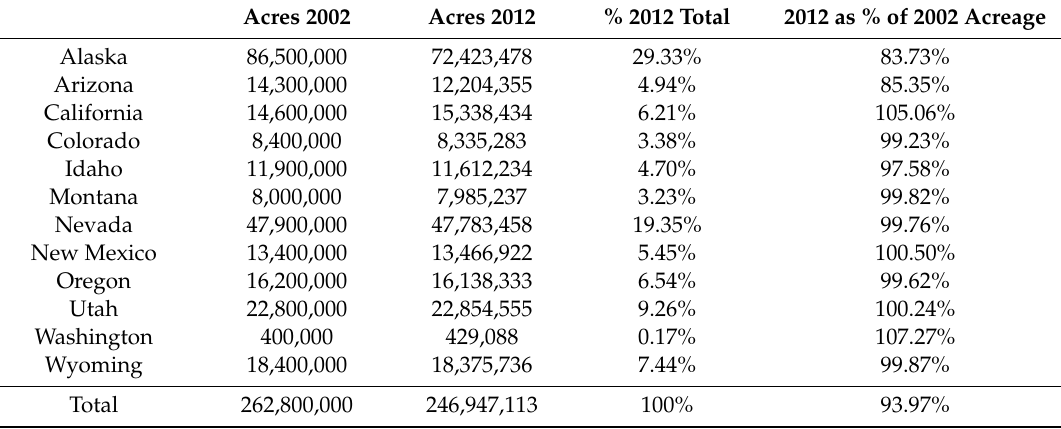
Table 1. BLM acreage data and percentage by state in 2002 and 2012. Source: Bureau of Land Management (BLM) of the